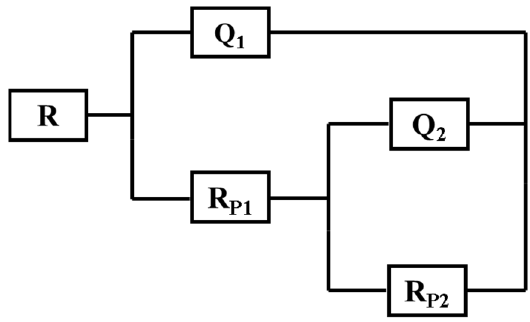
Figure 6. Obtained Nyquist plots for the nano-ZnO-incorporated coatings after 7 days of exposure.